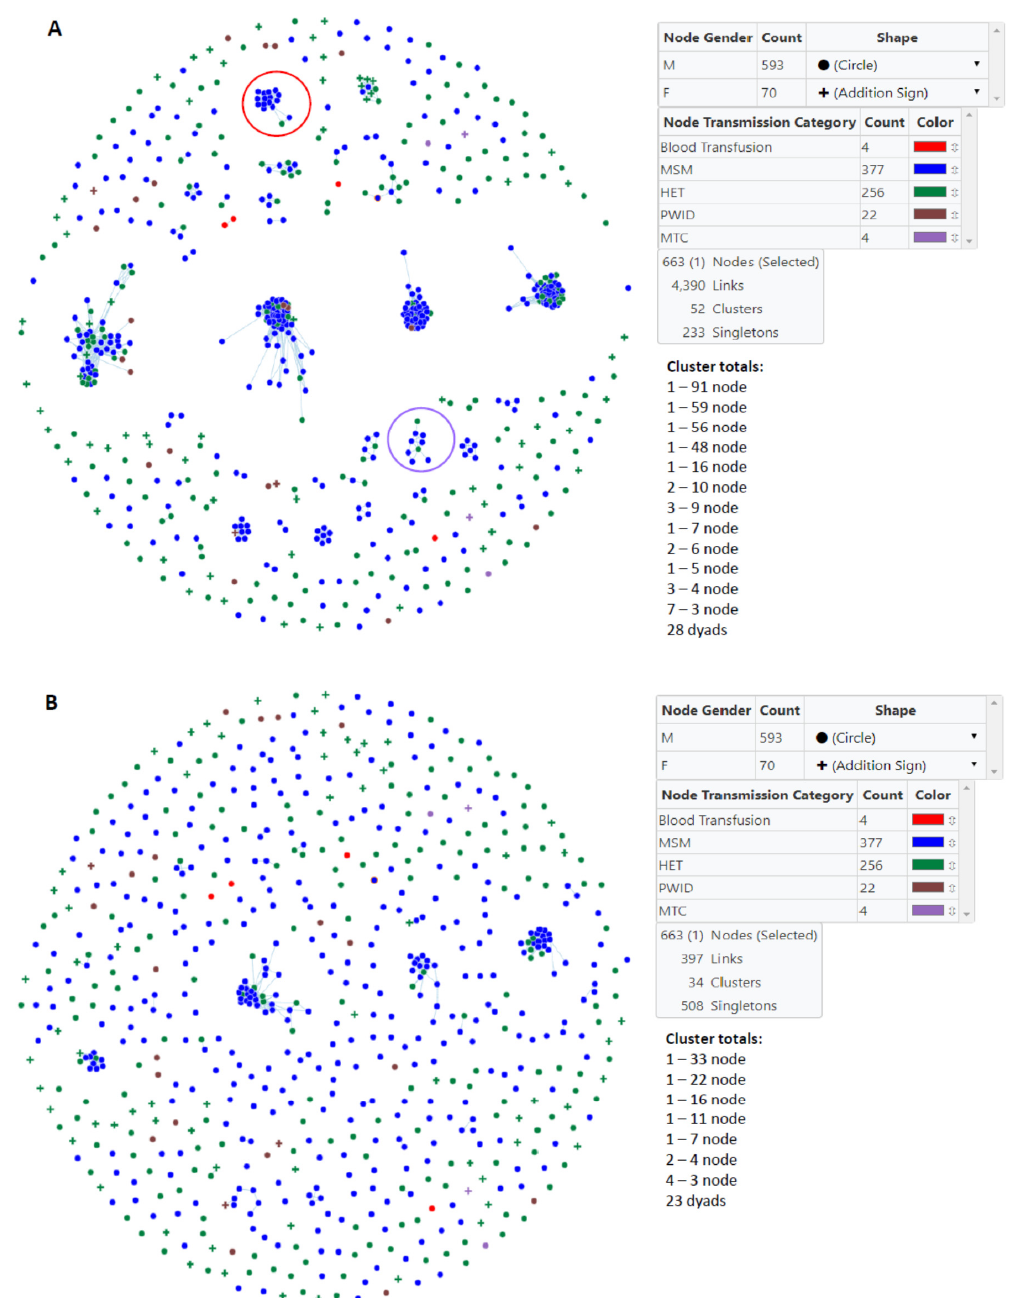
Figure 2. Inference of subtype B clusters in Bulgaria using MicrobeTrace. ( A ) A total of 52 clusters were identified using a genetic distance of 1.5% compared to ( B) 34 clusters at a genetic distance of 0.5%. Gender is indicated by circles (male) and addition signs (female). Transmission category is indicated with color (red, blood transfusion; blue, men who have sex with men (MSM); green, heterosexual (HET); brown, persons who inject drugs (PWID); purple, mother-to-child (MTC). One person reporting MSM and PWID risks was included in the MSM group. Cluster totals by node (members) and total number of links in the transmission network is provided. Large clusters with most of the members have HIV infection with drug resistance mutations at the 1.5% threshold are circled in red (nonnucleoside reverse transcriptase inhibitors) and purple (protease inhibitors).